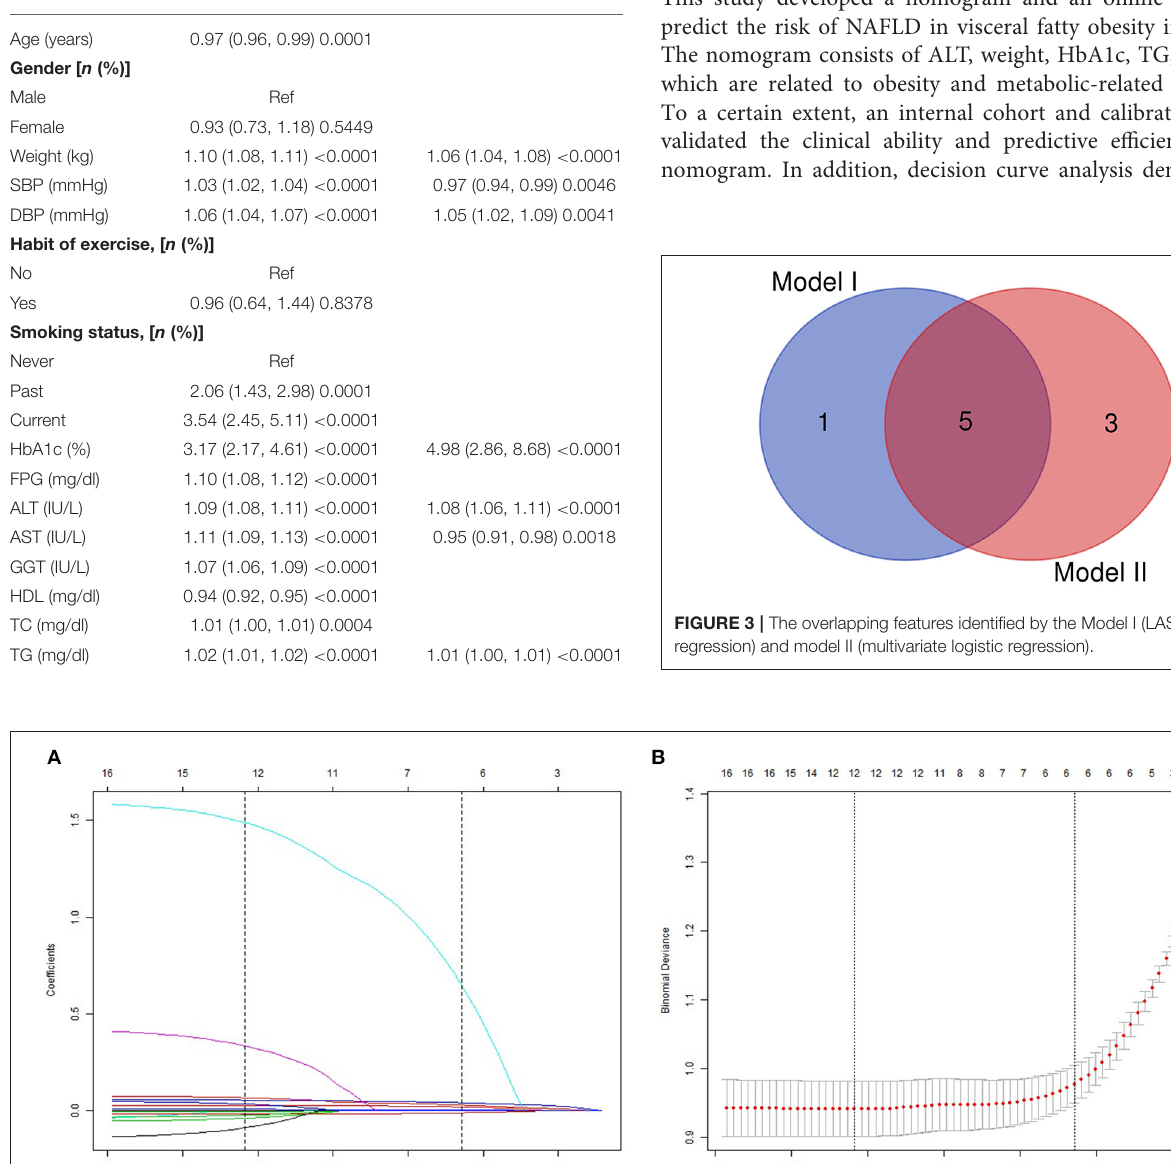
TABLE 2 | Univariate and multivariate logistic regression analysis for risk factors associated with fatty liver diseases in the training cohort. Characteristics Univariable